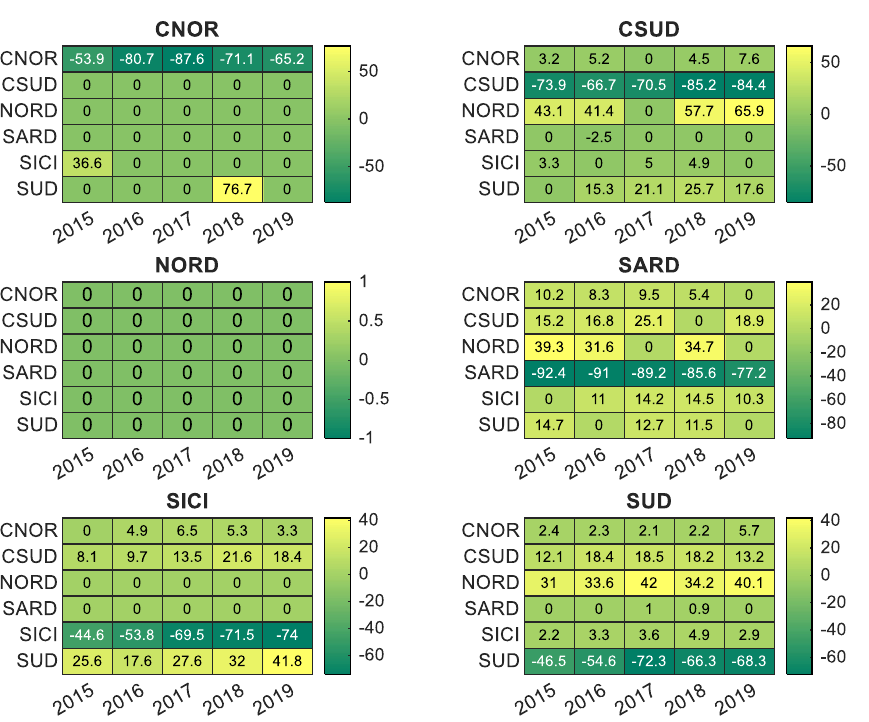
Figure A1. Heatmap chart of the impact of 100 MWh increases in wind generation on the net input flow (MW); results of Equations (1) and (2).